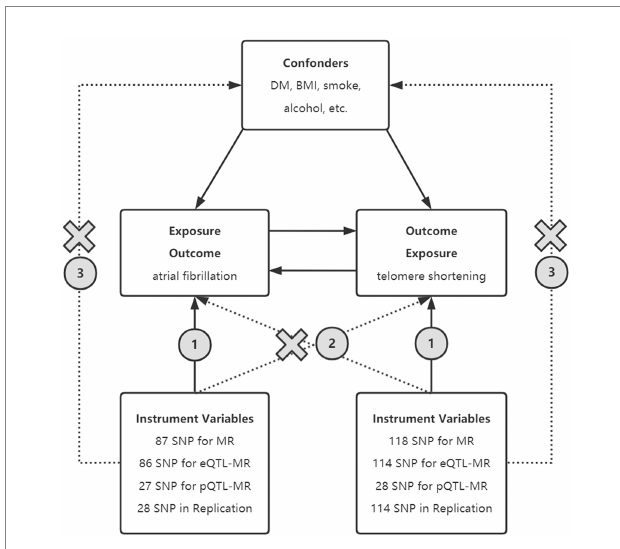
FIGURE 1 Principle of bidirectional Mendelian randomization. Selected SNPs as instrument variables in MR, eQTL-MR, and pQTL-MR analyses are strongly associated with exposure. The instrumental variables must be independent of the confounding factors and should only influence the outcome through exposure rather than other means. SNPs, single nucleotide polymorphism; BMI, body mass index; UKB, United Kingdom Biobank; eQTL, expression quantitative trait loci; pQTL, protein quantitative trait